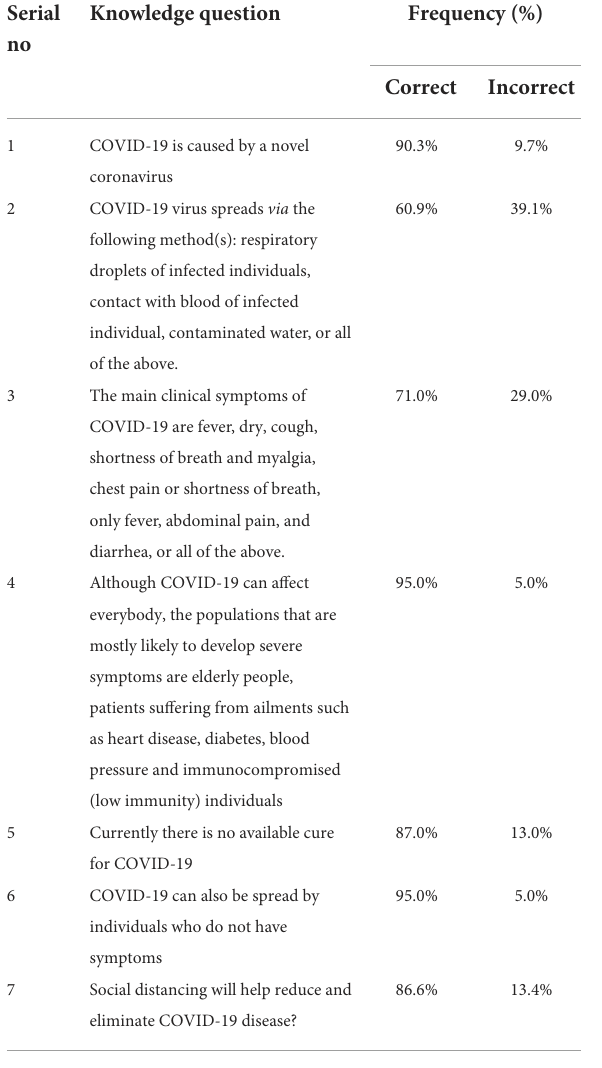
TABLE 2 Knowledge responses about COVID-19 among solid organ transplant recipients ( N = 238).